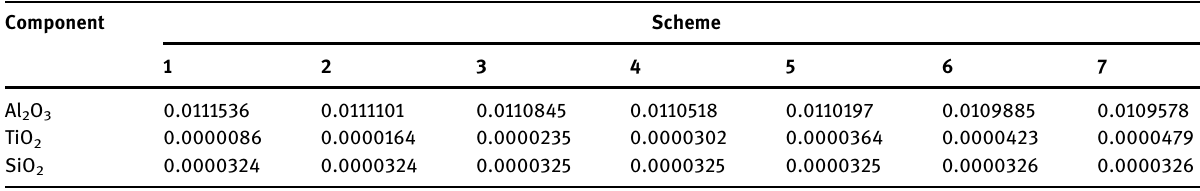
Table 3: The activities of Al 2 O 3 , TiO 2 , and SiO 2 in the di ff erent re fi ning slag Component Scheme